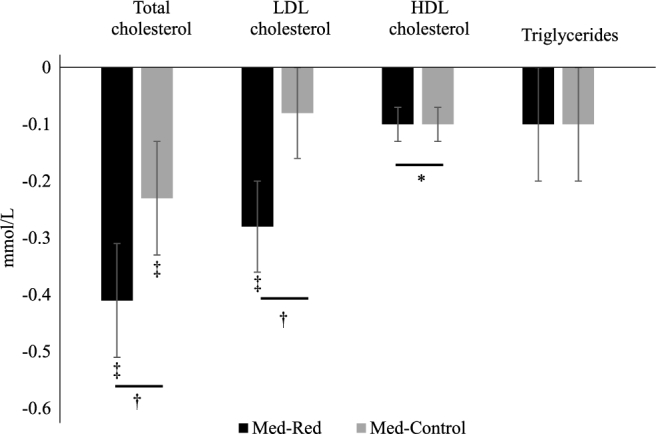
Changes in lipids and lipoproteins after consuming a Med-Red or Med-Control diet for 5 wk. Results are presented as LS means ± SEMs (n = 41). Data were analyzed using a doubly repeated-measures ANOVA adjusted for age, sex, and body mass at each time point. *Nondifferential change over time. †Differential response between Med-Red and Med-Control when intervention × time P value < 0.05. ‡Intervention-specific change over time indicated by intervention × time P < 0.05. ApoB results followed a similar pattern as LDL cholesterol and are available in Supplemental Tables 1 and 2. Conversion factors are available at: http://www.amamanualofstyle.com/page/si-conversion-calculator. ApoB, apolipoprotein B; LS, least squares; Med-Control, Mediterranean-style eating pattern with ∼200 g lean, unprocessed red meat/wk; Med-Red, Mediterranean-style eating pattern with ∼500 g lean, unprocessed red meat/wk.